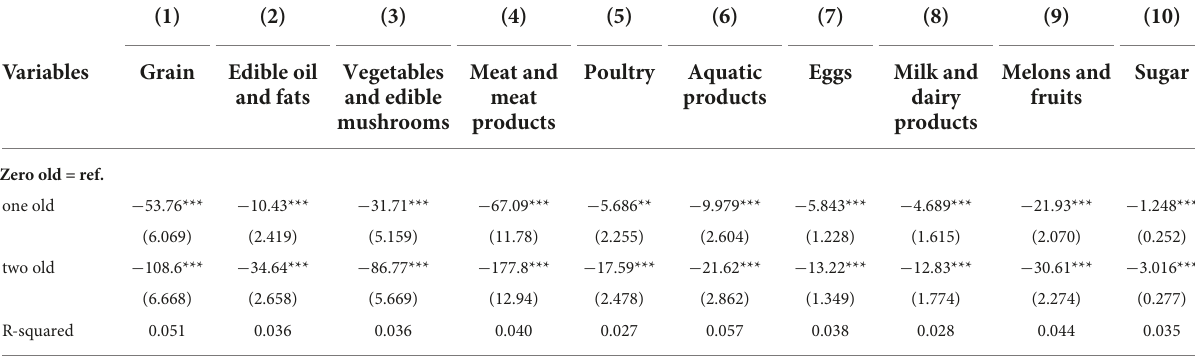
TABLE 2 Regression of the food consumption per capita on the number of older adults.